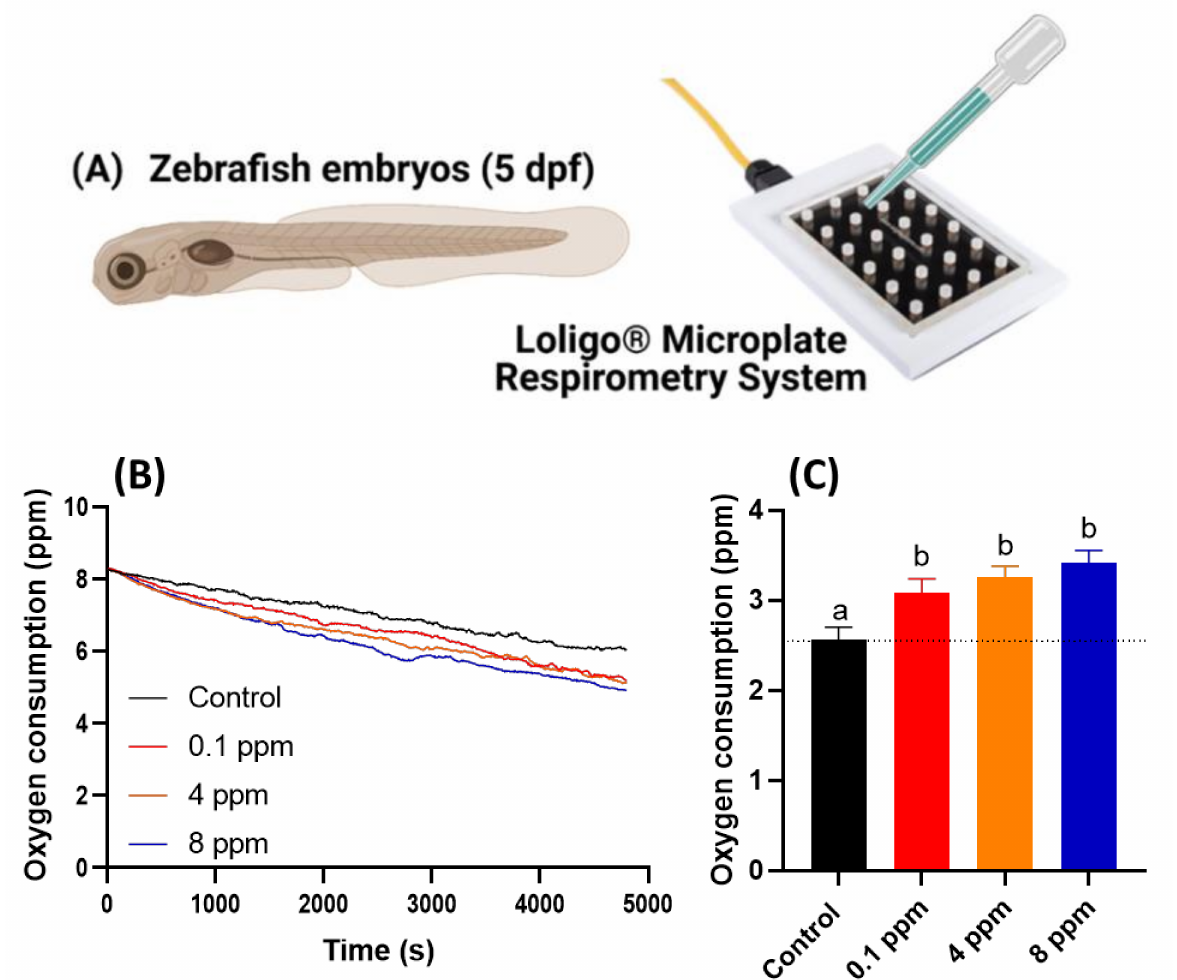
Figure 2. Oxygen consumption of zebrafish larvae at 5 dpf after 24-h incubation in different doses of RAC. ( A ) Experiment setting used to oxygen consumption measurement by using commercial instrument of Loligo Microplate Respirometry System. ( B ) The time chronology of dissolved oxygen level measured in the microplate. ( C ) The relative oxygen consumption for zebrafish embryos treated with different dose of RAC. The data are shown as the means ± SEM and analyzed by Two- way ANOVA either with Kruskal–Wallis One-way ANOVA test with Dunn’s correction as post-hoc multiple comparison test ( n = 43–46). Different letters a and b above columns indicate significant statistical differences with p < 0.05. Black bar: control, red bar: RAC 0.1 ppm, orange bar: RAC 4 ppm, and blue bar: RAC 8